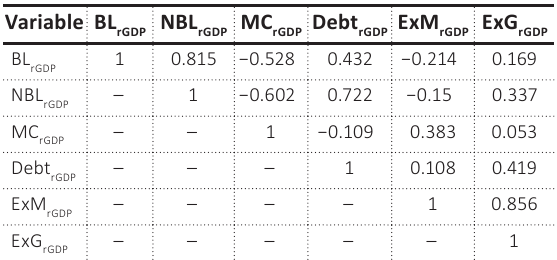
Table 3. Correlation matrix for variables